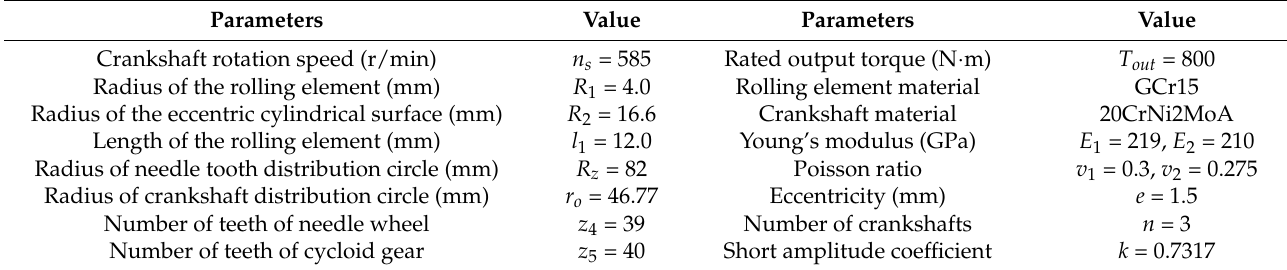
Figure 4. Transmission schematic diagram of RV Reducer. Table 1. Crankshaft-bearing rolling pair parameters.